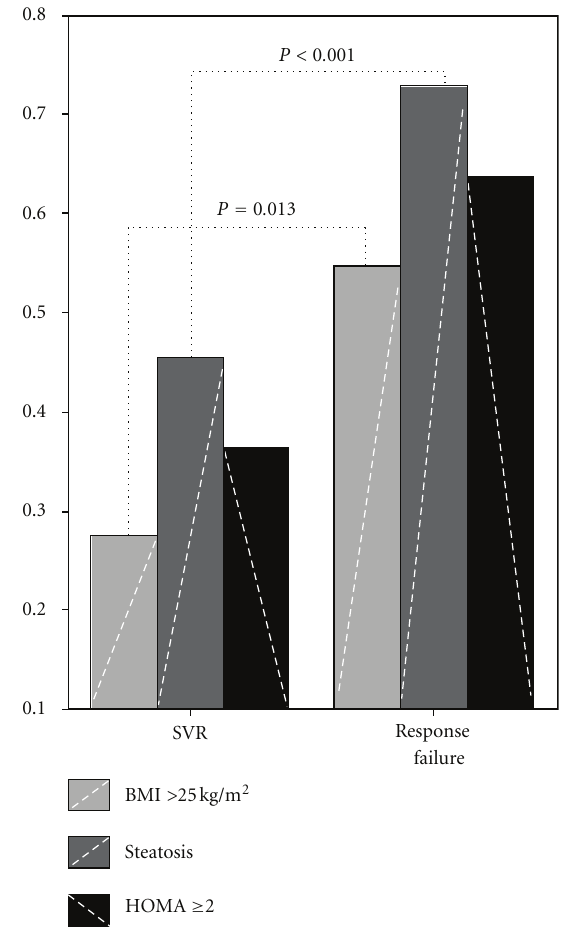
Figure 2: Prevalence of host metabolic factors in responders and